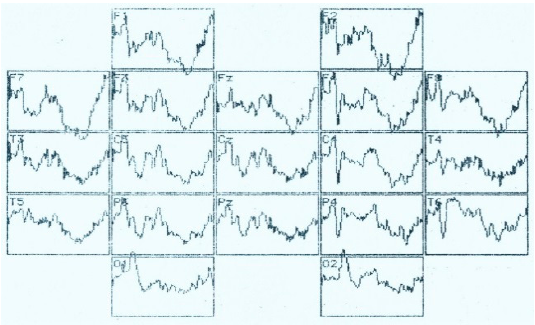
Figure 12. Distribution of VEP according to the 10–20 system in the perception of a recognizable visual image in a patient with meningioma of the right parietal lobe. Analysis time–1000 ms.